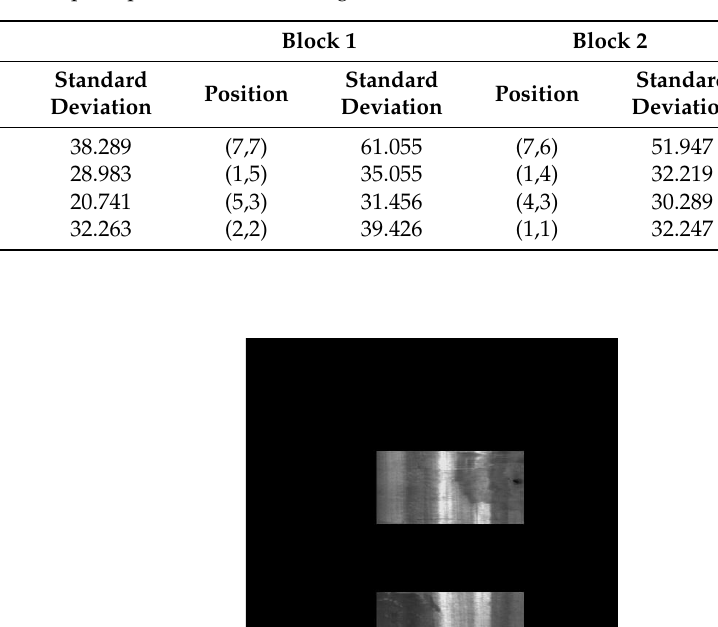
Table 1. Results of the ROI adaptive partition and blocking method.